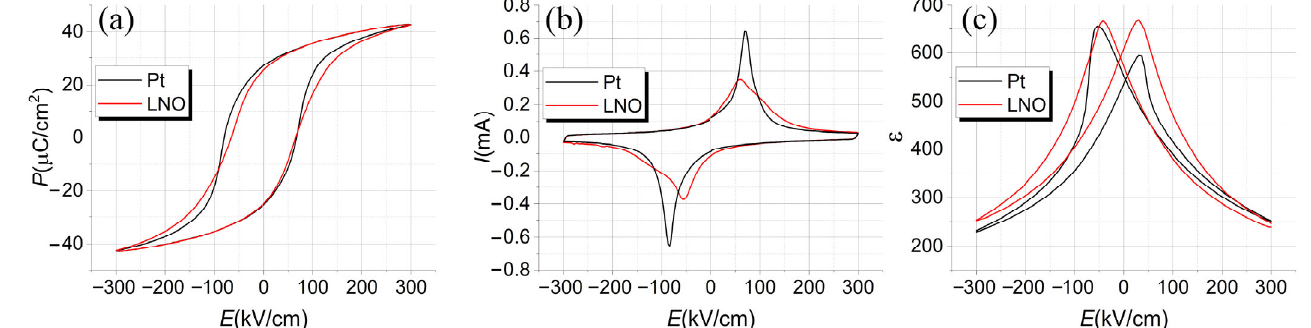
Figure 14. Dependences of polarization P ( a ), switching current I ( b ) and permittivity ε ( c ) on electric field strength E for PZT films on Pt (black lines) and LNO bottom electrode (red lines). Table 2. Electrical data of PZT ‐ Pt and PZT ‐ LNO structures.